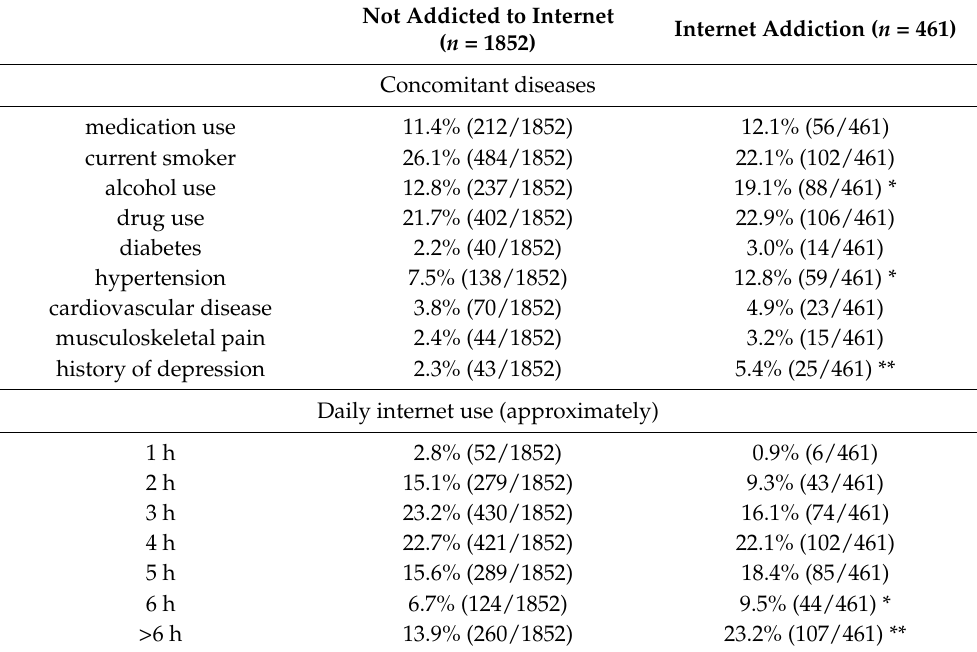
Table 4. Comparison of concomitant diseases, substance abuse and daily internet use in the study subgroups (* p < 0.05, ** p <